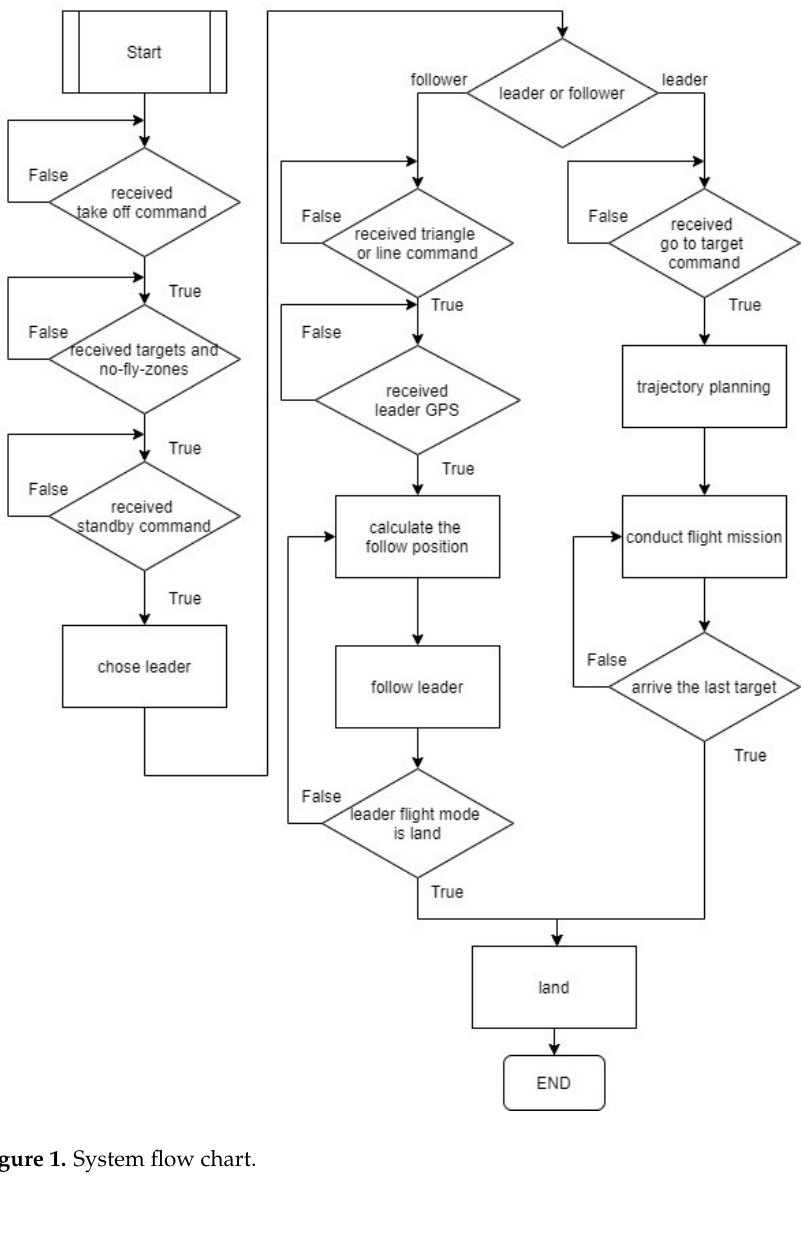
Figure 1. System flow chart.